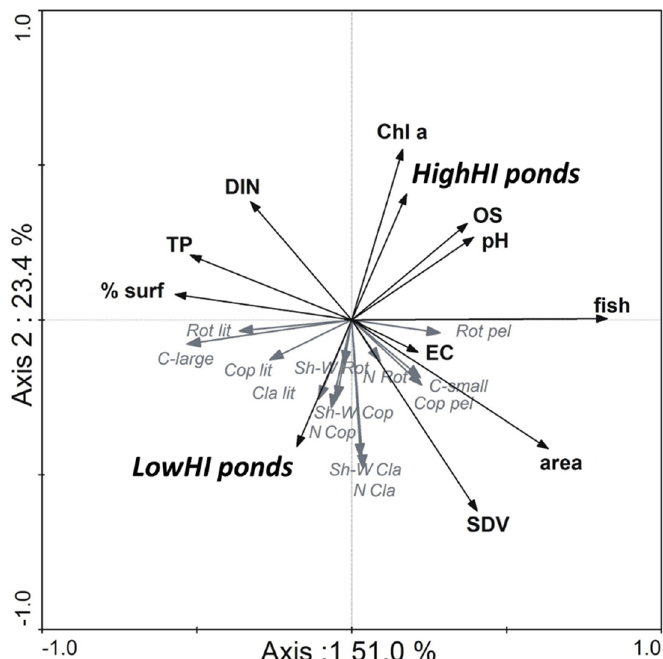
Figure 1. RDA diagram illustrating zooplankton community indices with physical-chemical variables in two types of water bodies: HighHI ponds—anthropogenically modified ponds and LowHI ponds—ponds of low level of human impact (legend: see Table 1).